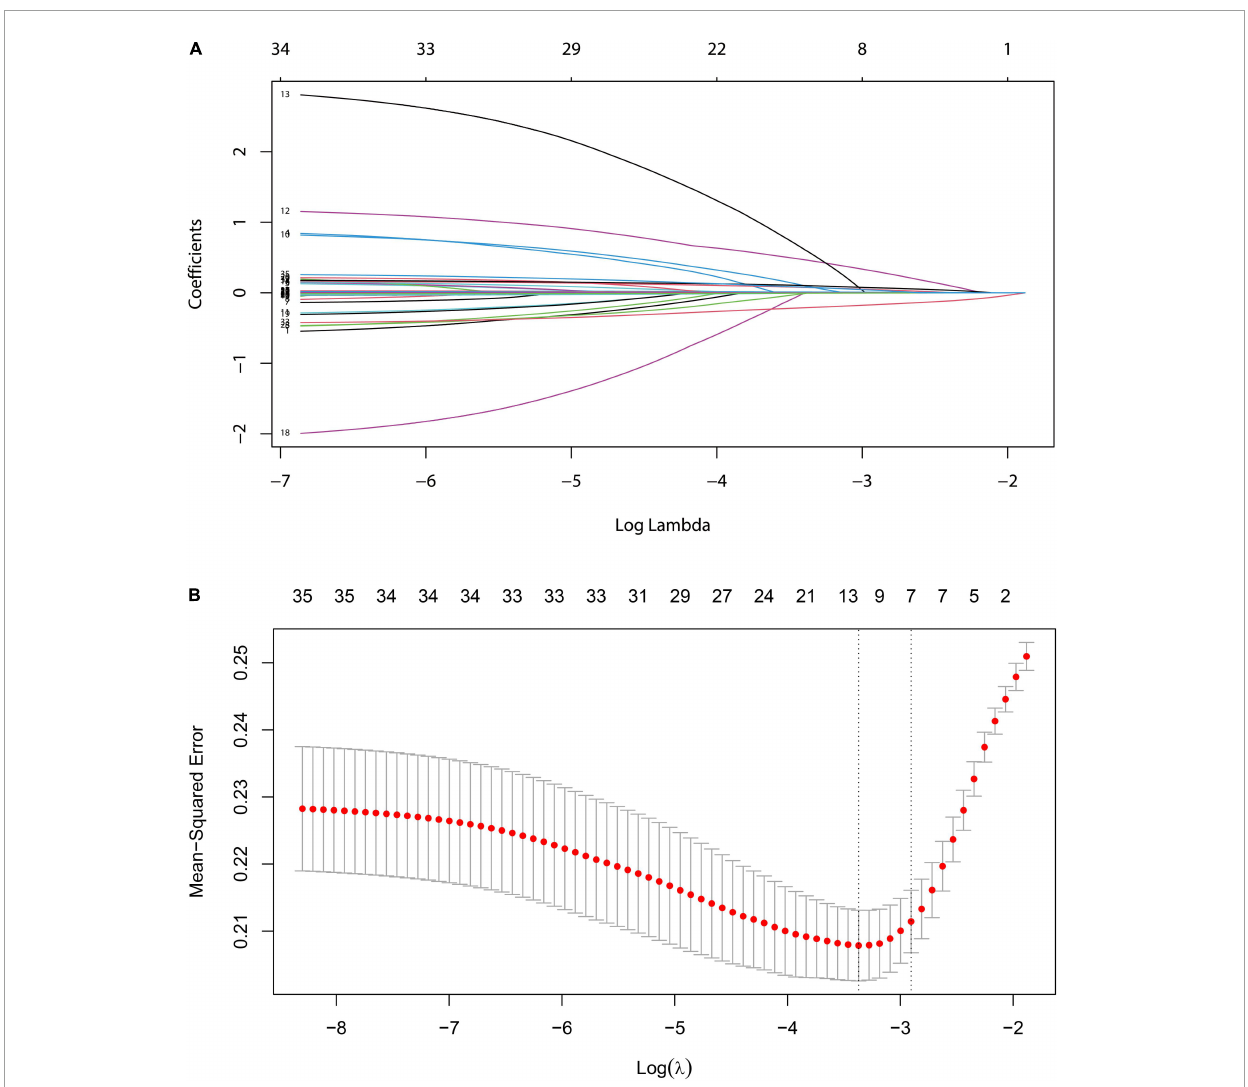
FIGURE3 LASSO logistic regression model for clinical feature selection. (A) Distribution diagram of the model was drawn for logarithmic (lambda) sequences under different penalty coefficients. (B) 10-fold cross-validation: The first vertical line is the minimum error, and the second line is the cross-validation error of 1-time minimum standard deviation.